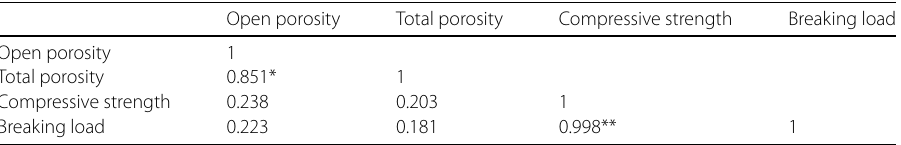
Table 5 Pearson correlation table of the physical and physical and mechanical properties of total porosity-open porosity and breaking load-compressive strength Open porosity Total porosity Compressive strength Open porosity